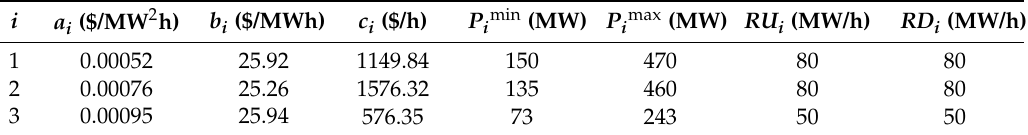
Table 1. Parameters of generation companies.